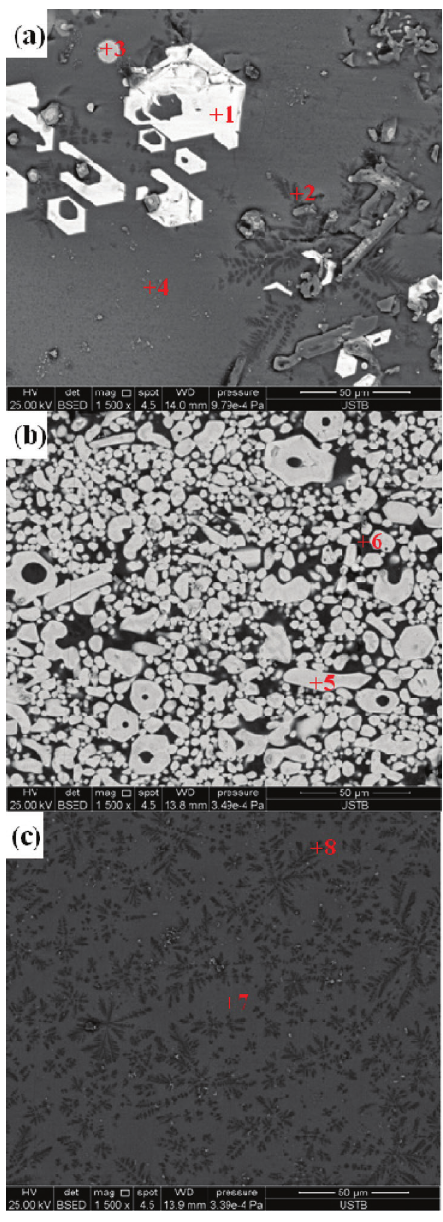
Fig. 7: Microstructure of separation products compared with the parallel sample: (a) parallel sample; (b) concentrate; (c)